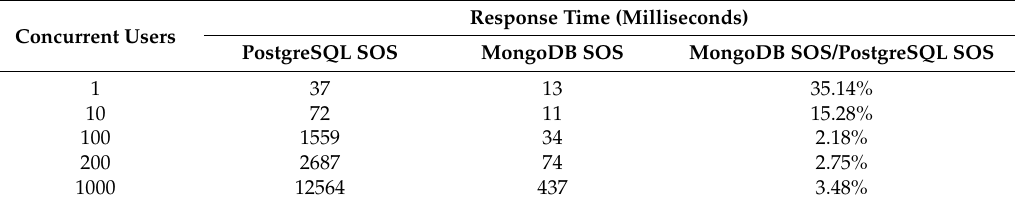
Table 4. The performance comparisons of the SOS GetObservation operation.